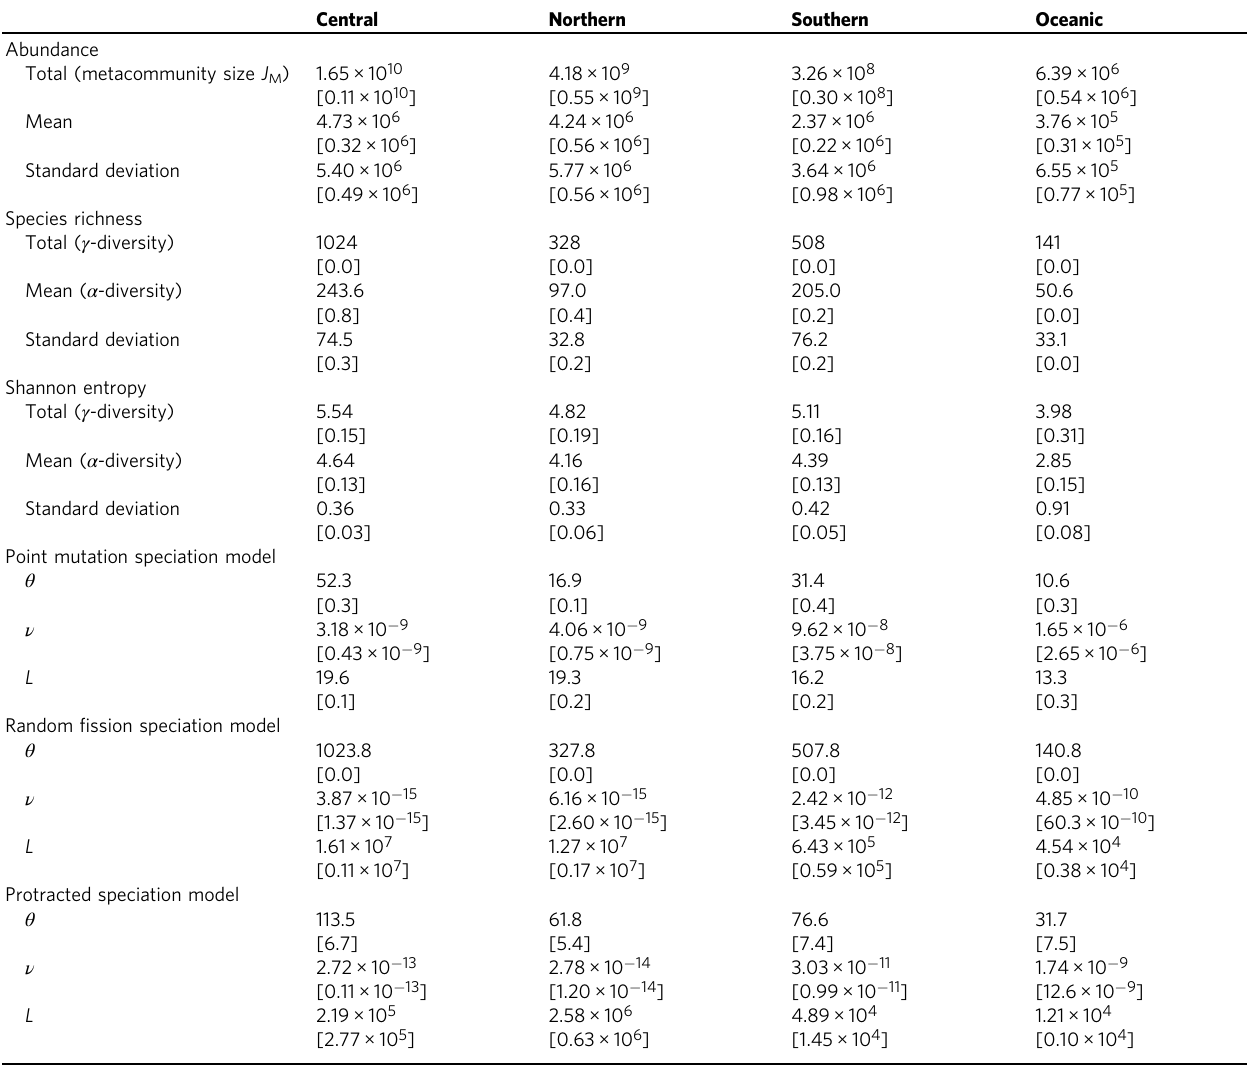
Table 3 Estimates of community abundance, species richness, diversity index, and parameters relevant to the uni fi ed neutral theory of